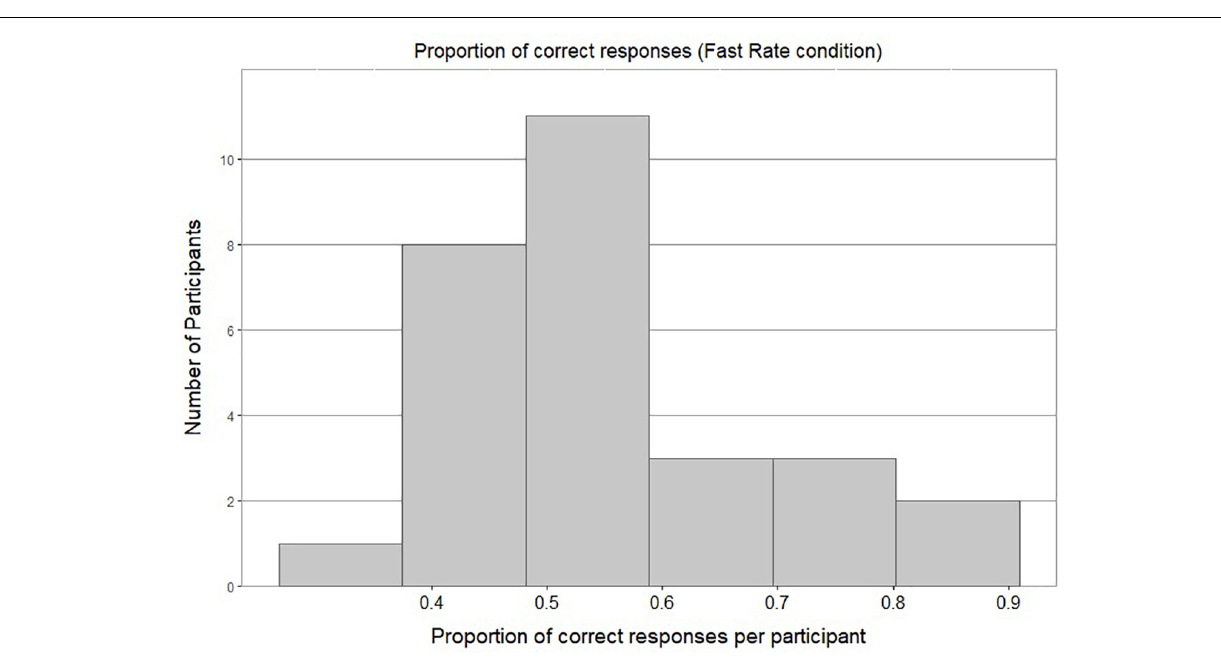
FIGURE 5 | Histogram of proportion of correct responses per participant in Fast Rate